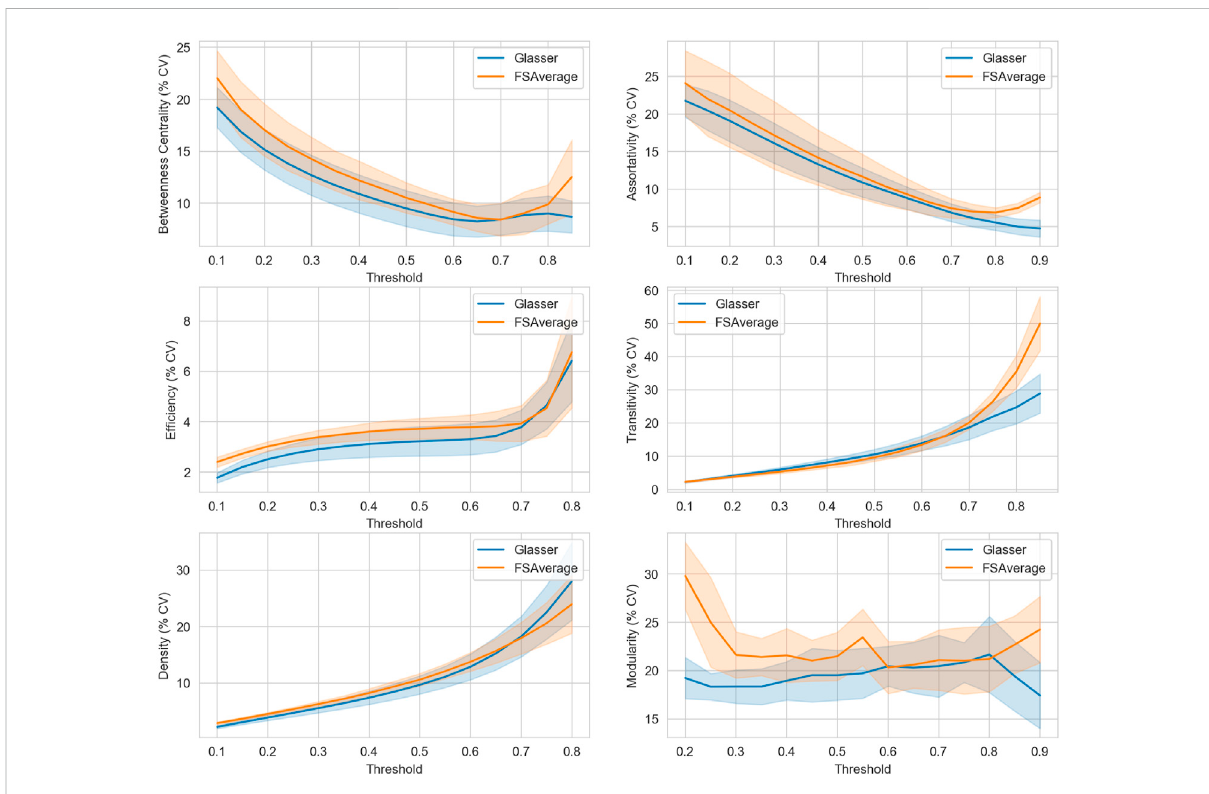
FIGURE 4 Variability study over the entire percentile threshold range, using two different atlases [FSAverage ( ) and Glasser 2016 ( a de fi ned global graph feature. For visual purposes, the upper and lower threshold values were cut off at a convenient value in order to avoid image fl